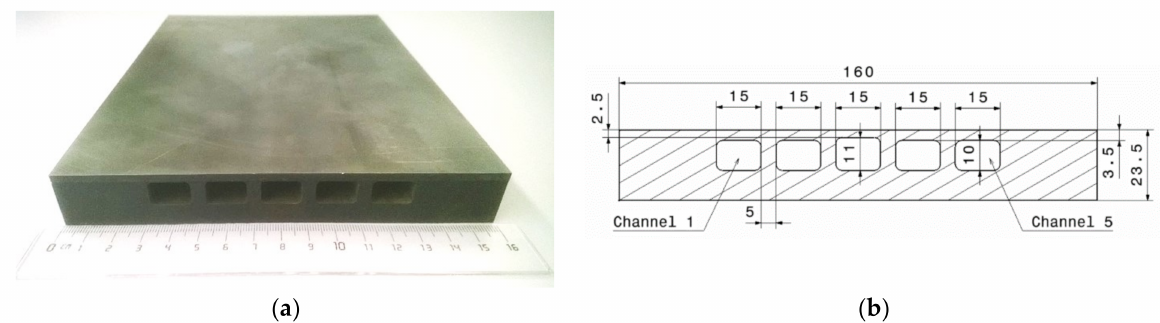
Figure 2. ODS mock-up: ( a ) the cooling plate with the cooling channels before the installation of the inlet/outlet manifolds; ( b ) cross-section through the mock-up with channels